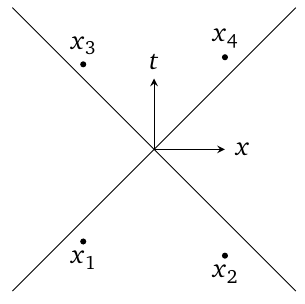
Figure 5.7: Configuration of example